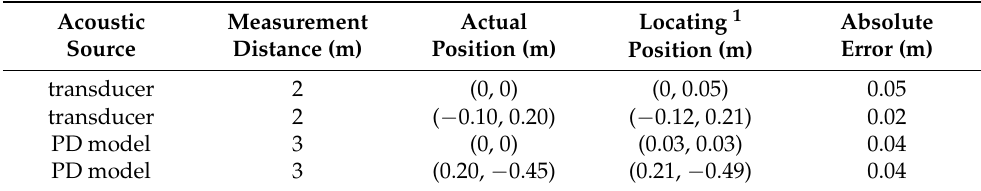
Table 2. The localization results and